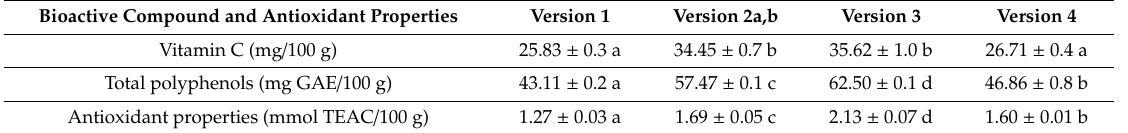
Table 4. Bioactive compound content and antioxidant properties in the designed beverages.